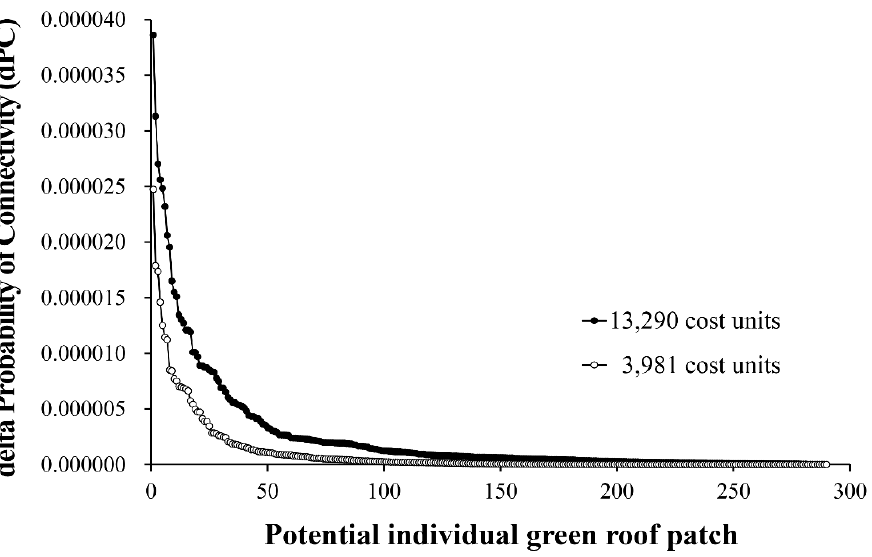
Figure 5. Contributions of potential individual green roof patches ( N = 290) sequentially added to maximize the improvement of overall tree canopy connectivity as measured by the delta Probability of Connectivity (dPC) at distances of 3981 and 13,290 cost units for the local and landscape scales, respectively, in Suwon City, Republic of Korea.